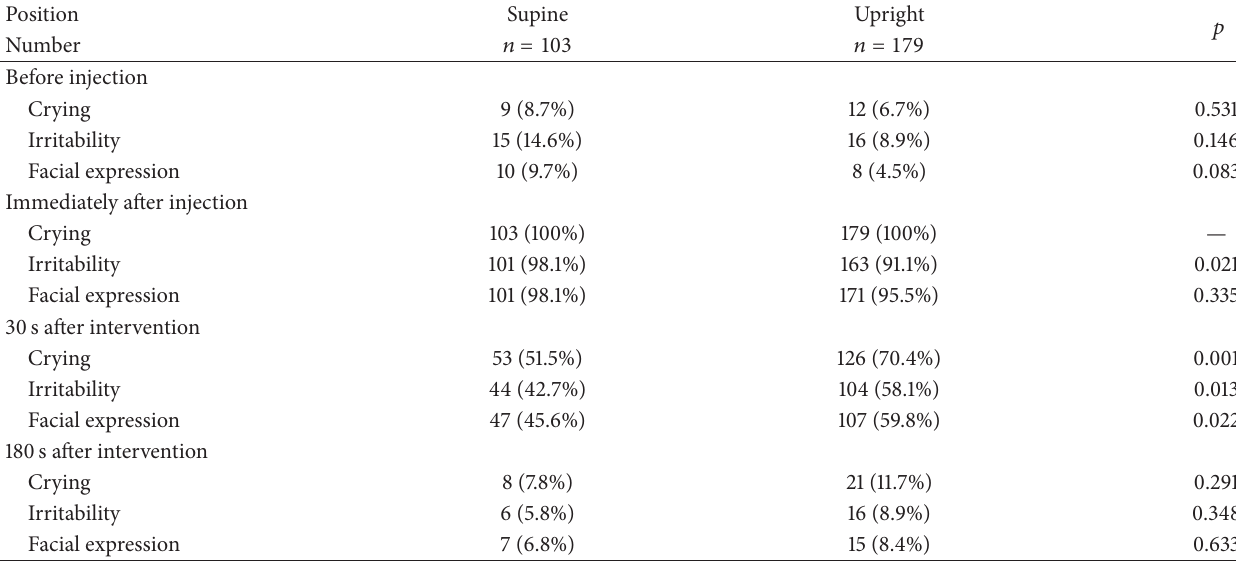
Table 4: Comparison of pain scales between the supine and upright positions by dichotomized measure ( 𝑛 = 282